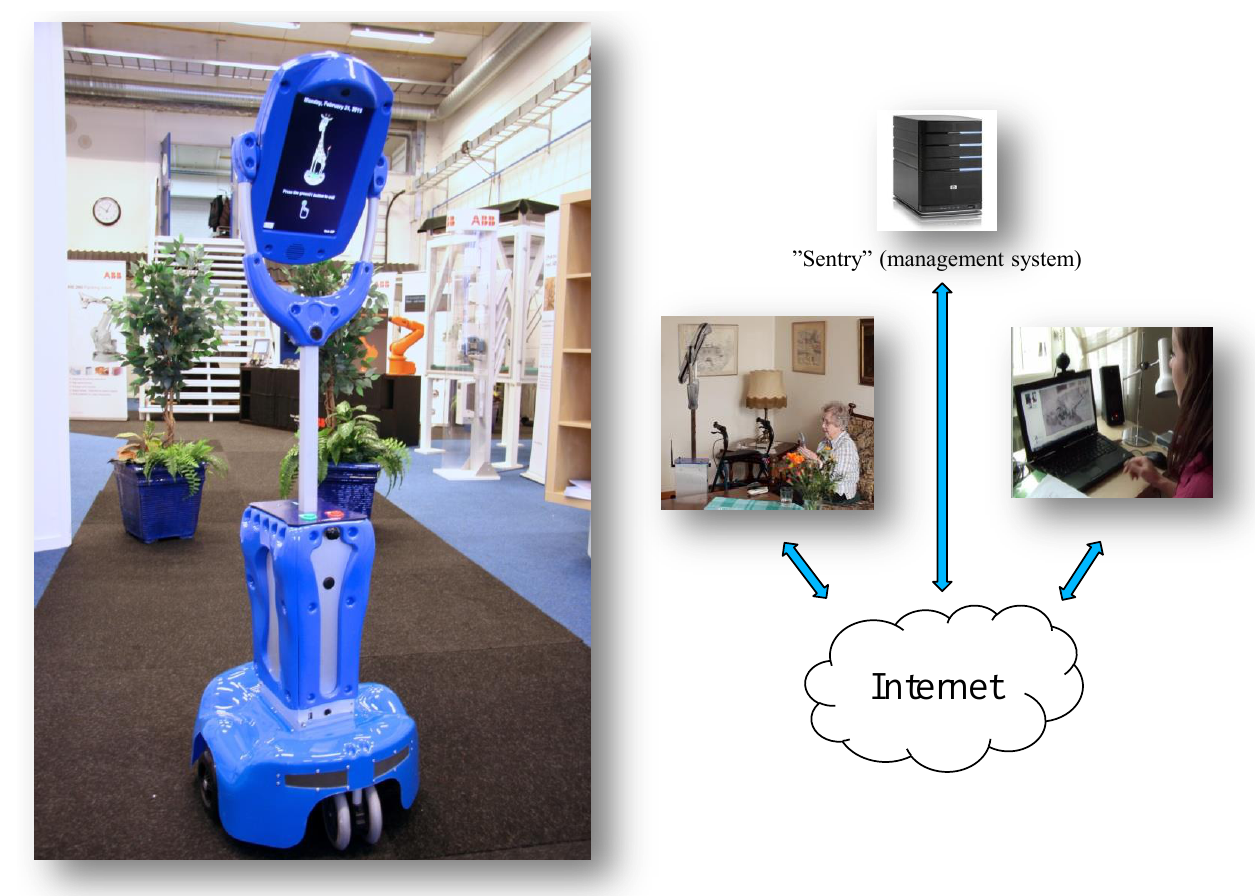
Figure 2. The Giraff